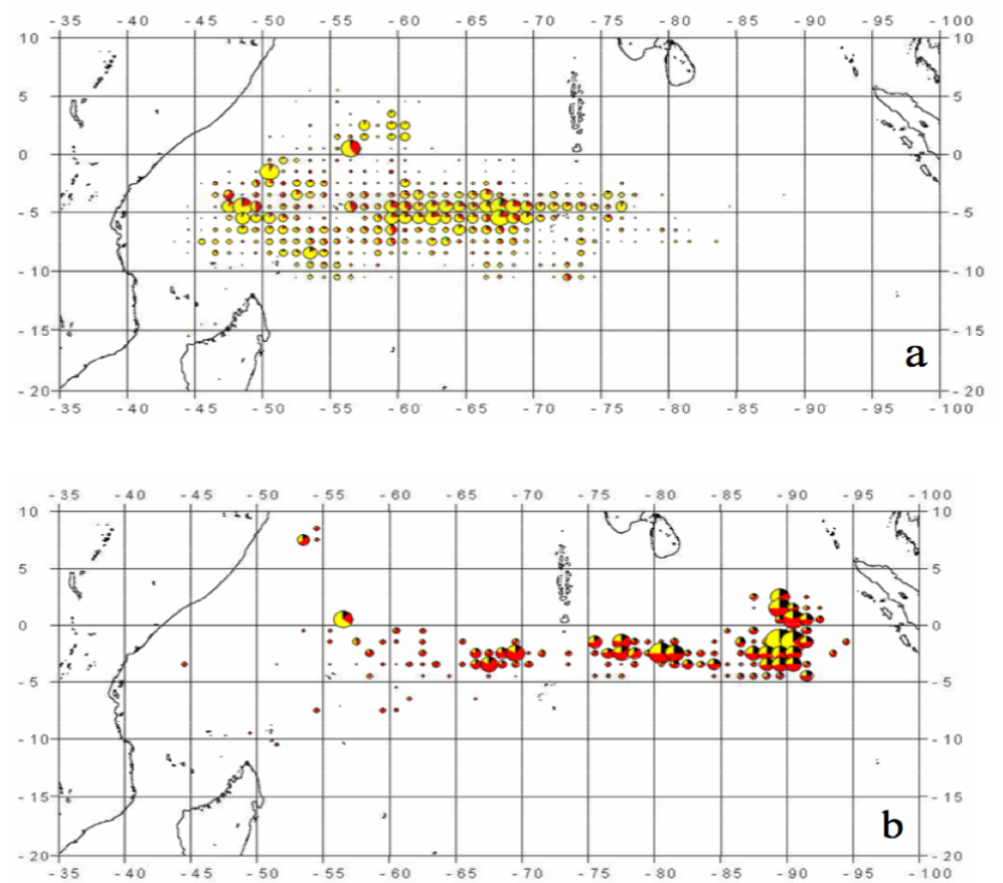
Figure 27. Tuna catch in the Indian Ocean during the 1997–1998 IOD event (b) compared to catch in normal years (a) . From Robinson et al. (2010), copyright Inter-Research